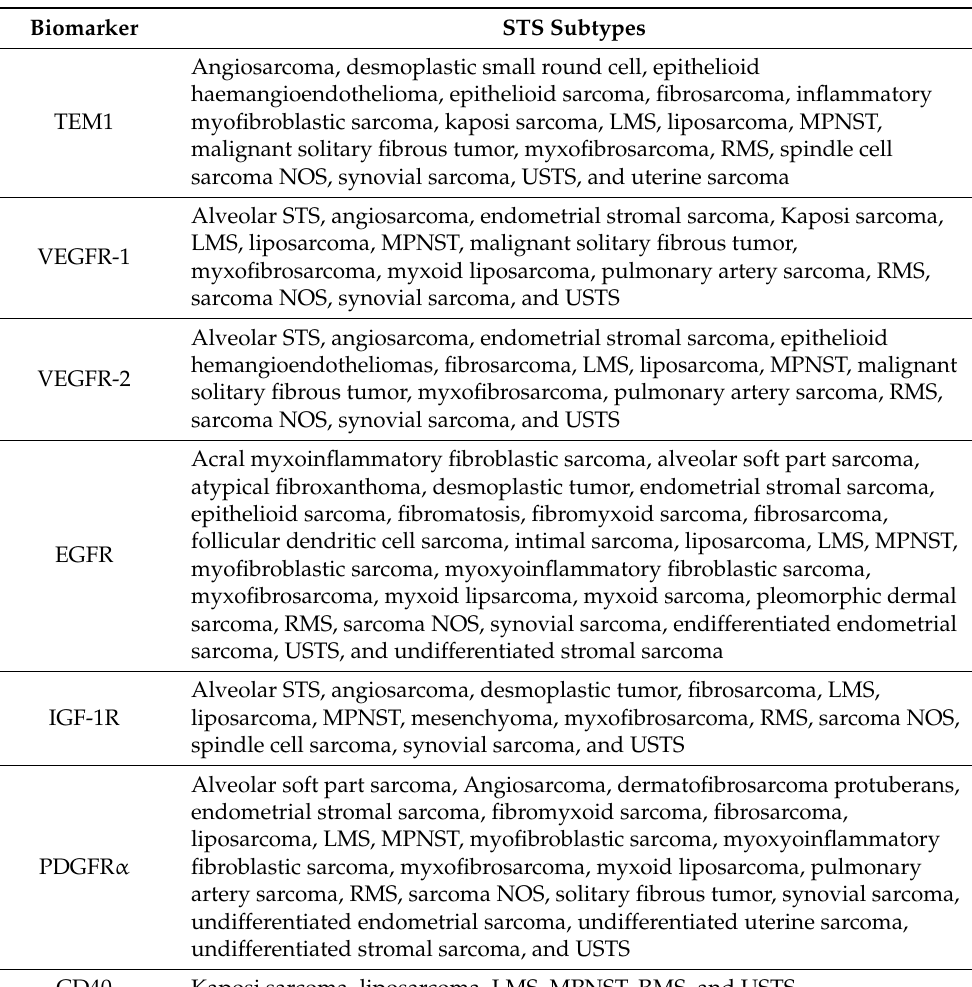
Table A1. Overview of the studied STS subtypes for each of the top 7